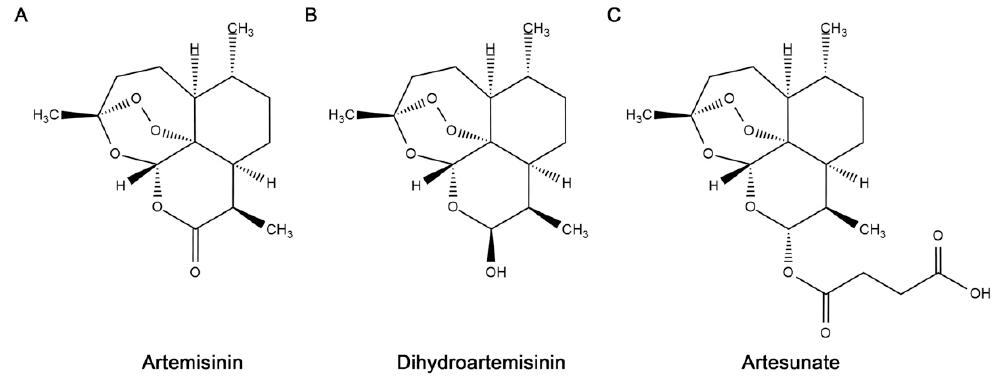
Figure 1. Structures of artemisinin and major derivatives prepared with ChemDraw Ultra, version 12.